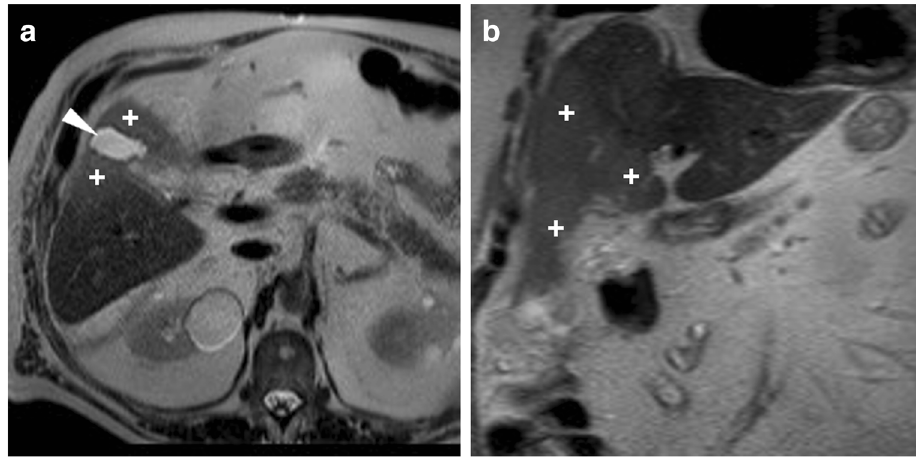
Fig. 8 Expected MR appearance 24 h after uncomplicated laparoscopic cholecystectomy: axial ( a ) and coronal ( b ) T2- weighted images showing small- sized fluid collection in the